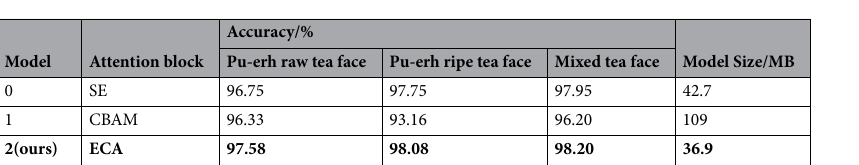
Table 9. Comparison of tea face recognition results under different attention mechanism modules. Significant are in value